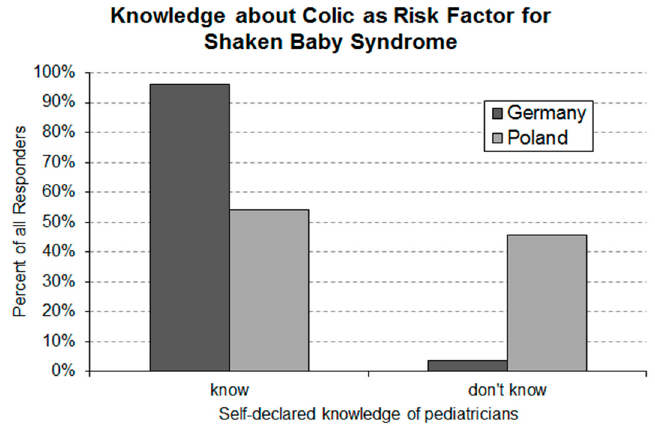
Figure 5. Self-declared knowledge of German ( n = 159) and Polish ( n = 133) pediatricians about infantile colic being a risk factor for shaken baby syndrome. Statistical analysis using the standard Asymptotic Pearson Chi-Squared Test revealed a highly significant ( p -value = 2.2 × 10 − 16 ) between-country difference.